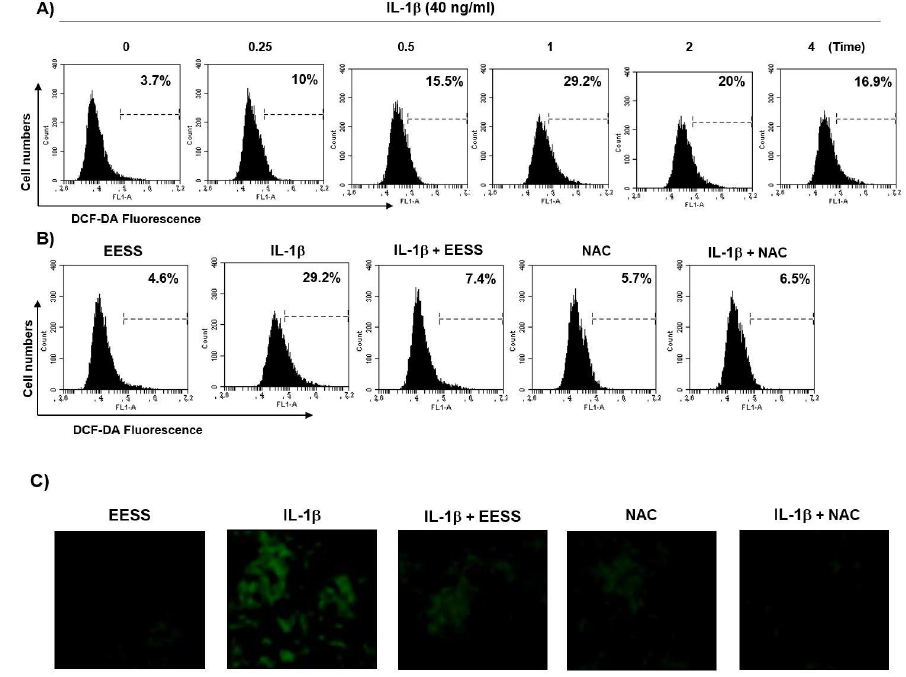
Figure 2. Effects of EESS on IL-1β-induced reactive oxygen species (ROS) generation in SW1353 chondrocytes. Cells were pretreated with 300 μg/mL EESS for the indicated times ( A ), or pretreated with 300 μg/mL EESS or 10 mM NAC for 1 h, and then stimulated with or without 40 ng/mL IL-1β for 1 h ( B , C ). ( A , B ) Cells were incubated with 10 μM 5,6-carboxy-2′,7′-dichlorofluorescin diacetate (DCF-DA) for 30 min at 37 °C. The cells were collected, and DCF fluorescence was measured by flow cytometry. Values represent the means of two independent experiments. ( C ) Images were obtained by fluorescence microscopy, and those presented are from one experiment, and are representative of at least three independent experiments.